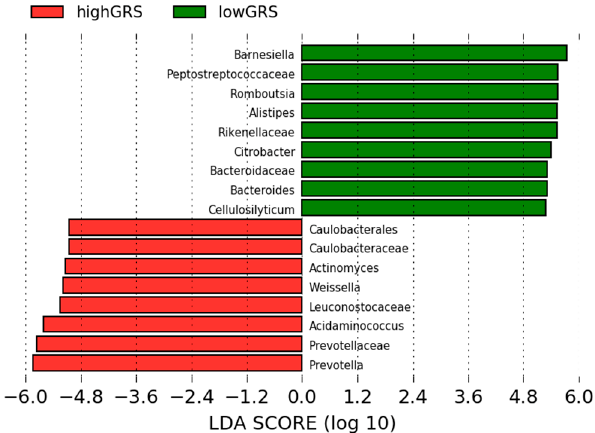
Figure 2. Linear discriminant analysis effect size between subjects with high Genetic Risk Score and subjects with low Genetic Risk Score Red, bacterial taxa statistically overrepresented in high Genetic Risk Score participants; green, bacterial taxa overrepresented in low Genetic Risk Score participants.